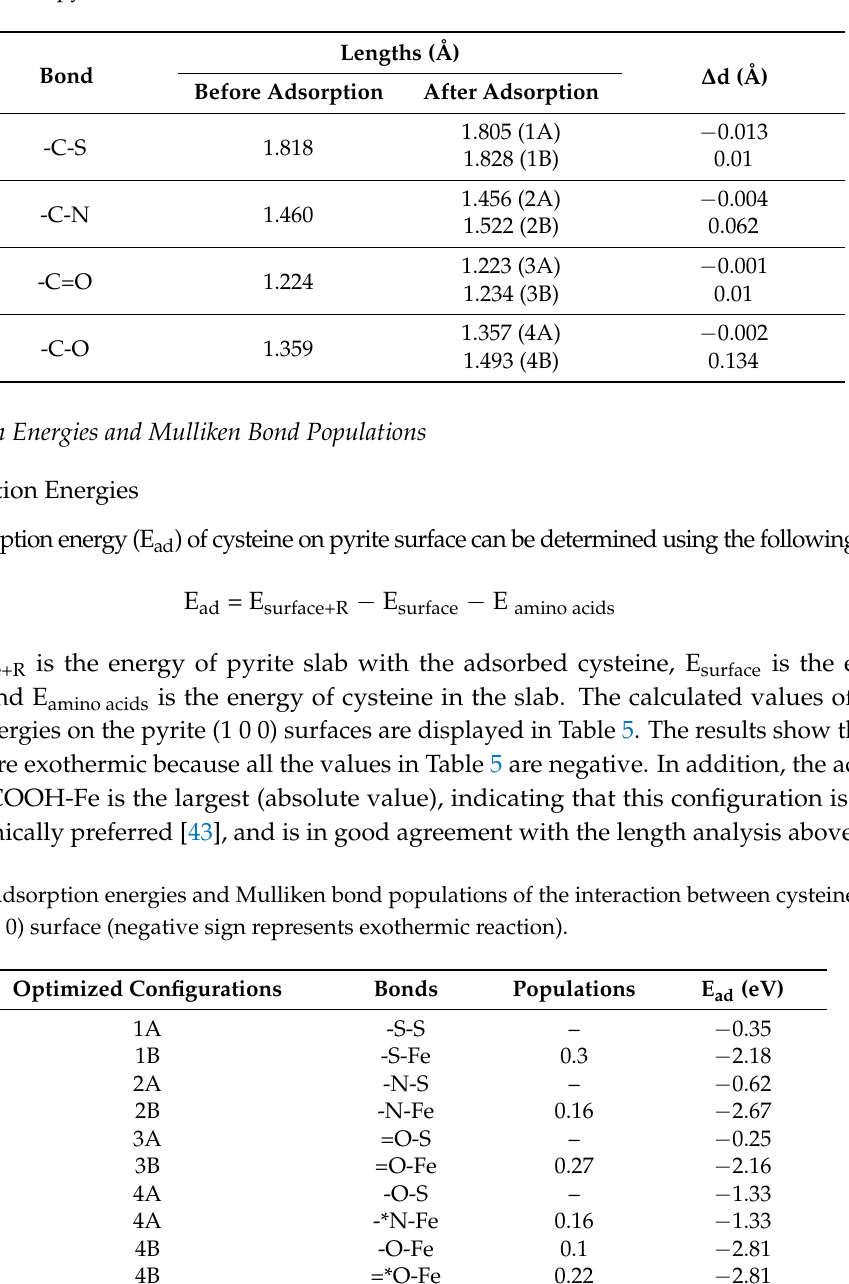
Table 4. The lengths values (Å) of C-S, C-N, C=O, and C-O of cysteine before and after adsorption on surface Fe/S of pyrite.